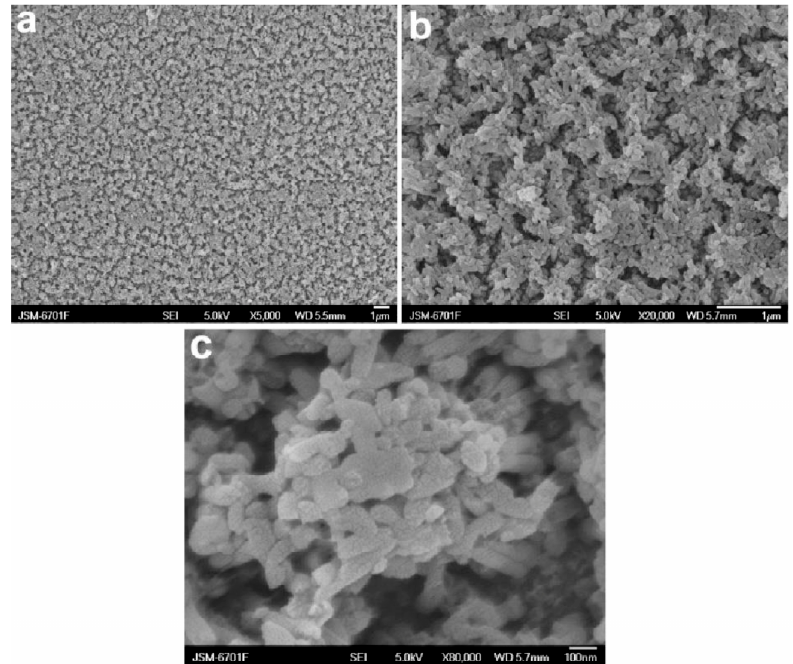
Figure 1. Field-emission scanning electron microscopy (FE-SEM) images at different magnifications of the as-prepared polyaniline (PANI) nanowire superhydrophobic surface: ( a ) 5000×, ( b ) 20,000× and ( c ) 80,000× [47]. Reprinted with permission from [47]; 2008 ACS Publications.